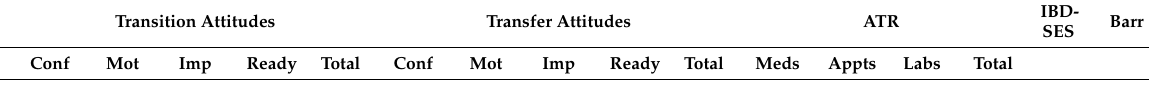
Table 3. Bivariate Correlations Between Study Variables.